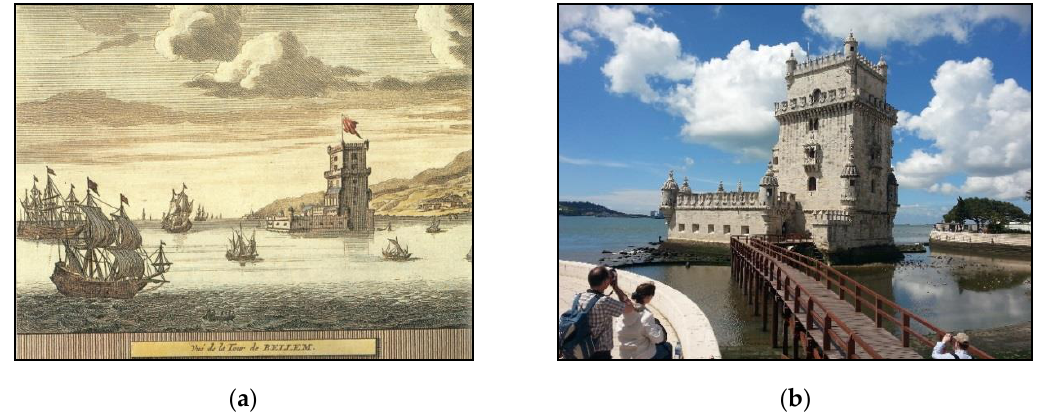
Figure 1. ( a ) Old illustration of the Tower of Belém [1]; ( b ) The tower as it stands today.